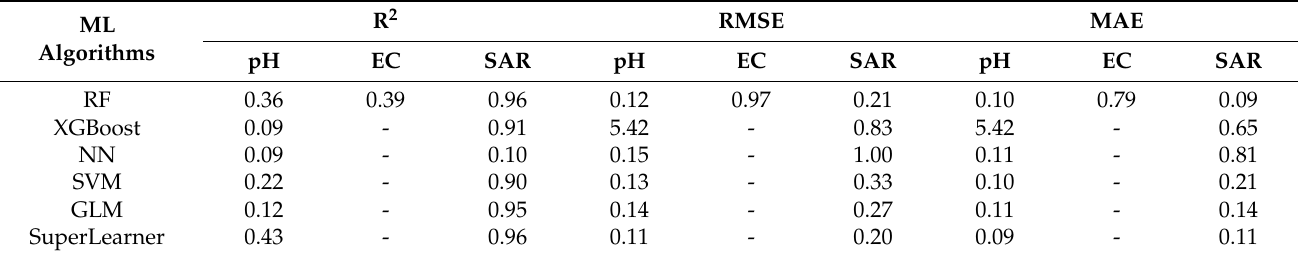
Table 3. Evaluation metrics summary for ensemble